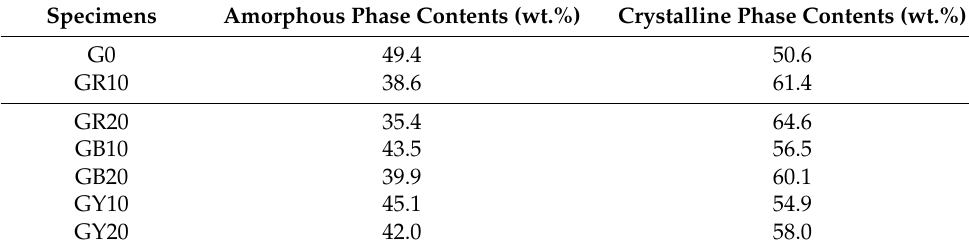
Table 1. Amorphous and crystalline phase contents